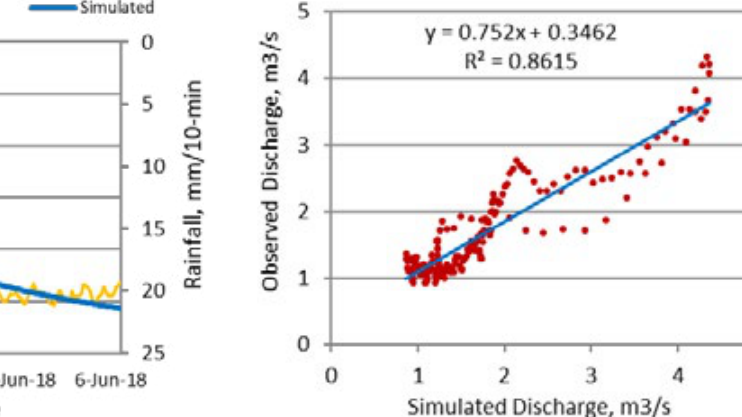
Fig. 4: Hydrograph for observed and simulated discharge data Fig. 5: Correlation between observed and simulated discharge data